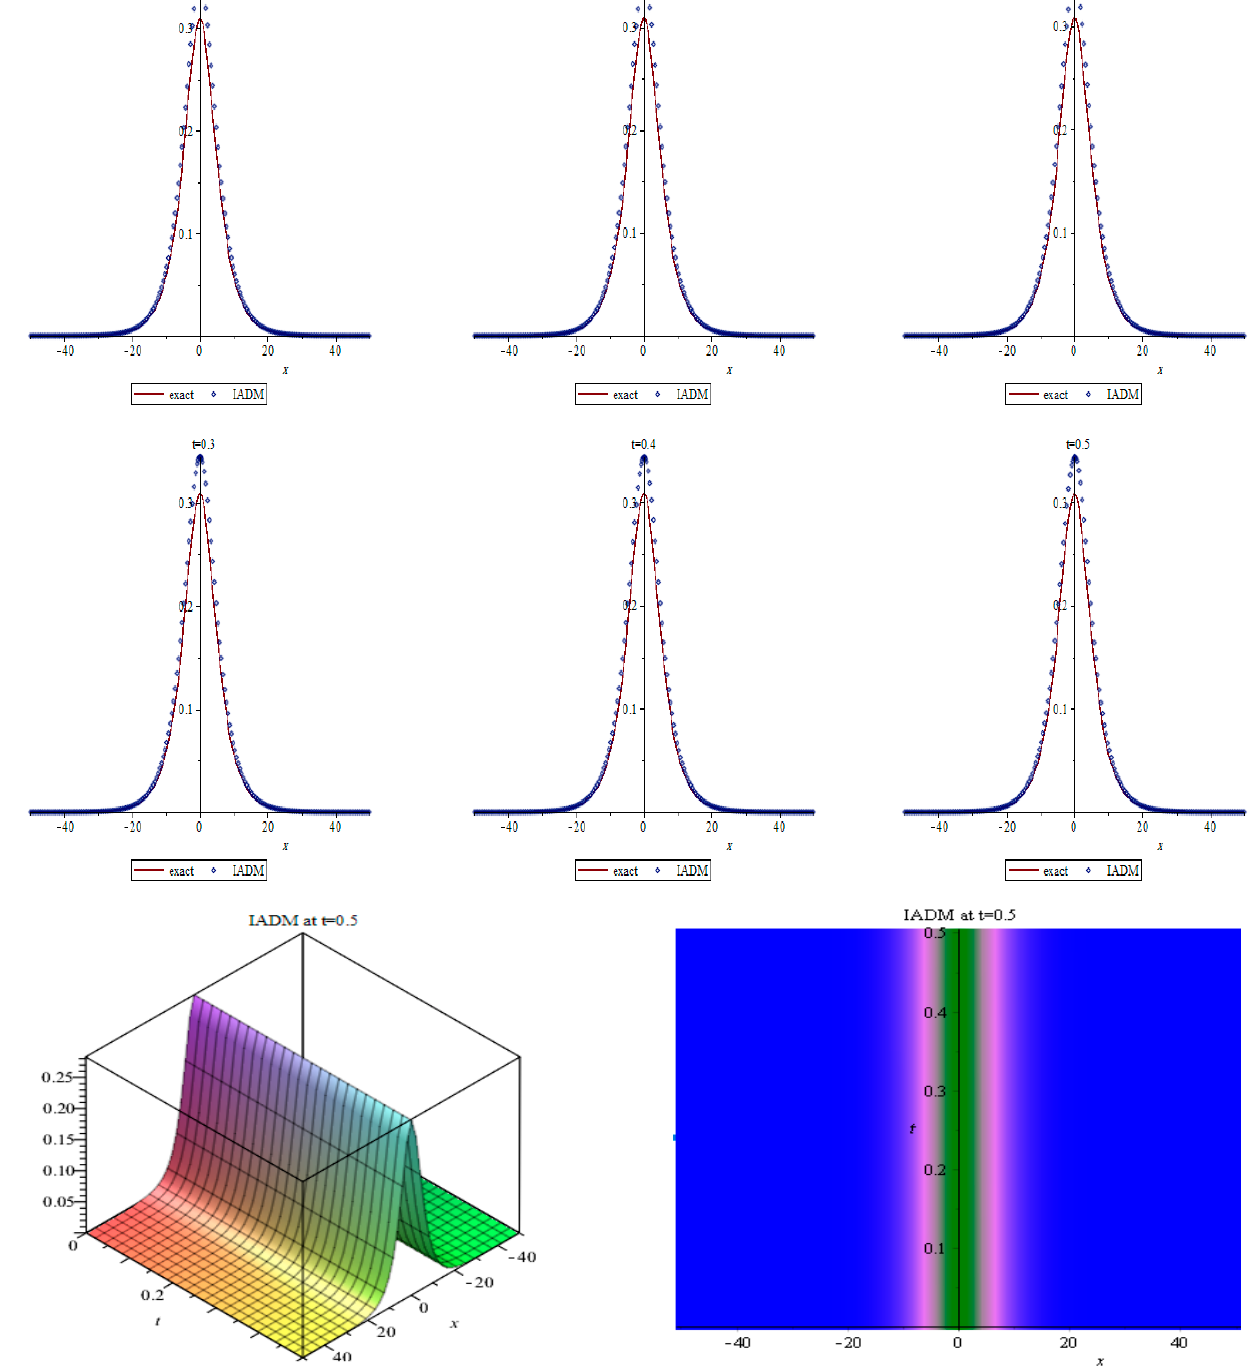
Figure 3. Comparison of the exact and improved ADM solutions for case 3 for − 50 ≤ x ≤ 50. Table 1. Absolute error for Case 1 for x = 20, x = 50.